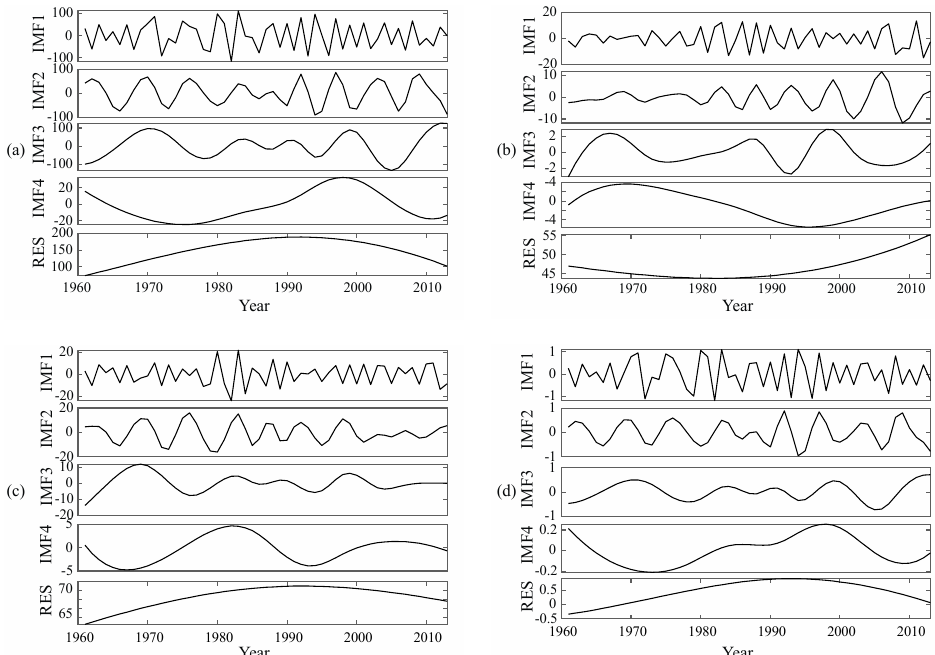
Figure 4. IMFs and the trend component of ( a ) The plum rainfall. ( b ) The onset of Plum Rains. ( c ) The termination of Plum Rains. ( d ) The daily intensity of plum rainfall during the period of 1960 to 2012. It is necessary to conduct significant tests in order to determine whether each component is a result of simple noise, or a signal that has physical meaning. In Figure 5, the horizontal coordinate represents periodic data and the vertical coordinate represents the energy spectrum density with four confidence levels, which are 80%, 90%, 95%, and 99%. It indicates that the IMF passes the significance test and has many physical meanings if it falls above the confidence level. Otherwise, IMF contains pure white noise. In other words, more or less physical meaning actually means strong or weak oscillations within a certain range. IMF1, IMF2, and IMF3 of plum rainfall fell above the confidence level of 90% and IMF4 of plum rainfall fell between the confidence level of 80% and 90%. IMF1, IMF2, and IMF3 comprised a more definite physical meaning but not white noise, and IMF4 contained less physical meaning. IMF1 and IMF4 of the onset of Plum Rains fell above the confidence level of 95%, while IMF2 and IMF3 of the onset of Plum Rains fell below the confidence level of 90%. IMF1, IMF2, and IMF3 of the termination of Plum Rains fell above the confidence level of 90% while IMF4 fell below the confidence level of 90%. IMF1, IMF2, and IMF3 of the intensity of plum rainfall fell above the confidence level of 90%, while IMF4 fell below the confidence level of 80%.